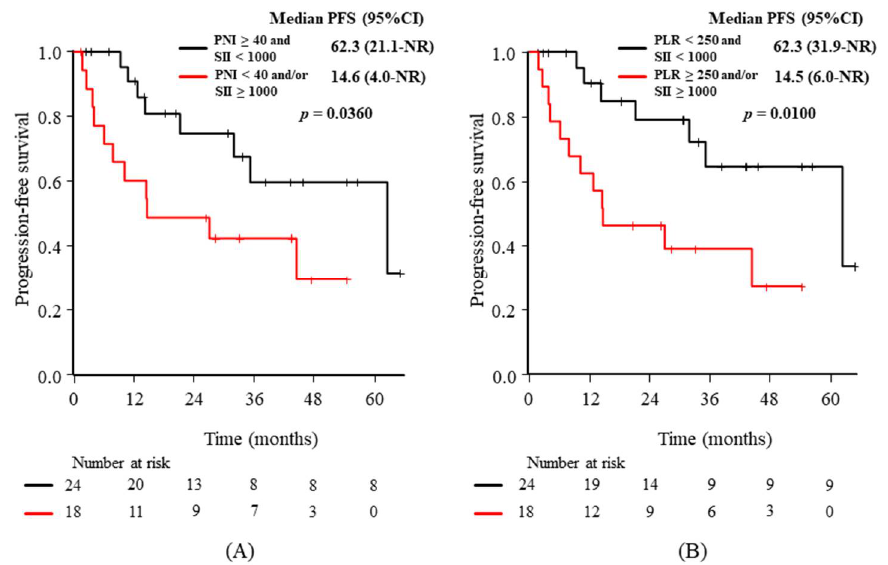
Figure 4. Kaplan–Meier curves of progression-free survival (PFS) according to the composite of 2 markers: ( A ) “prognostic nutrition index (PNI) ≥ 40 and systemic immune-inflammation index (SII) < 1000” vs. “PNI < 40 and/or SII ≥ 1000” and ( B ) “platelet-to-lymphocyte ratio (PLR) < 250 and SII < 1000” vs. “PLR ≥ 250 and/or SII ≥ 1000”. CI: confidence interval, NR: not reached.